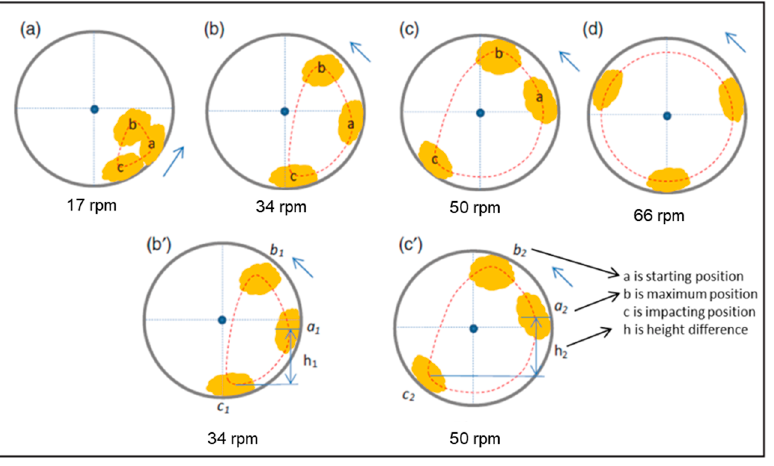
Figure 9. Fabric movement in the washing drum, ( a ) 17, ( b ) 34, ( c ) 50, and ( d ) 66 rpm [38]. (Repro- duced with permission).